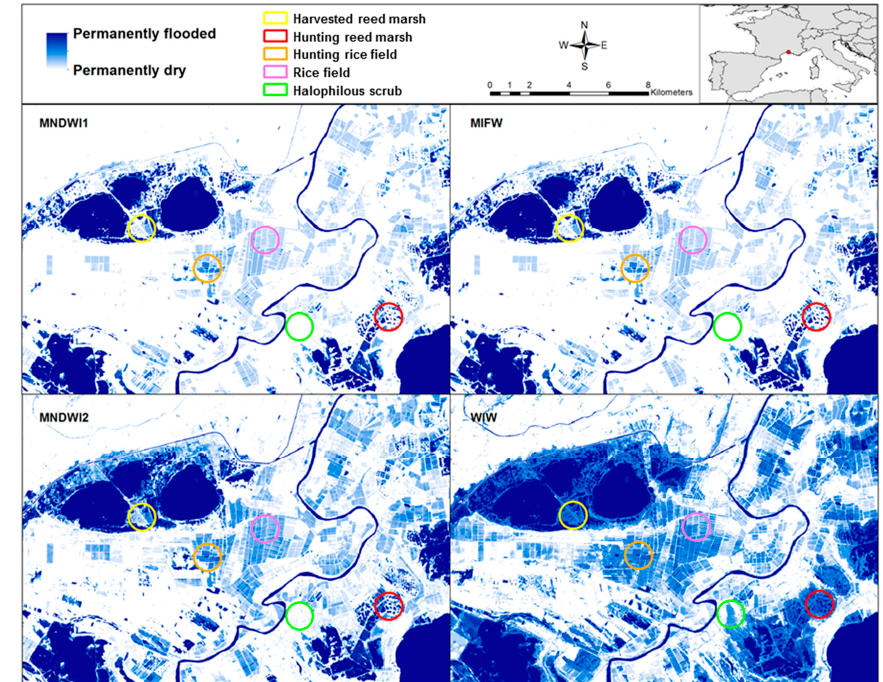
Figure 5. Annual water mask obtained with 12 monthly scenes of Sentinel 2 (from December 2017 to November 2018) when applying the water indices having the highest Kappa values in Table 5.